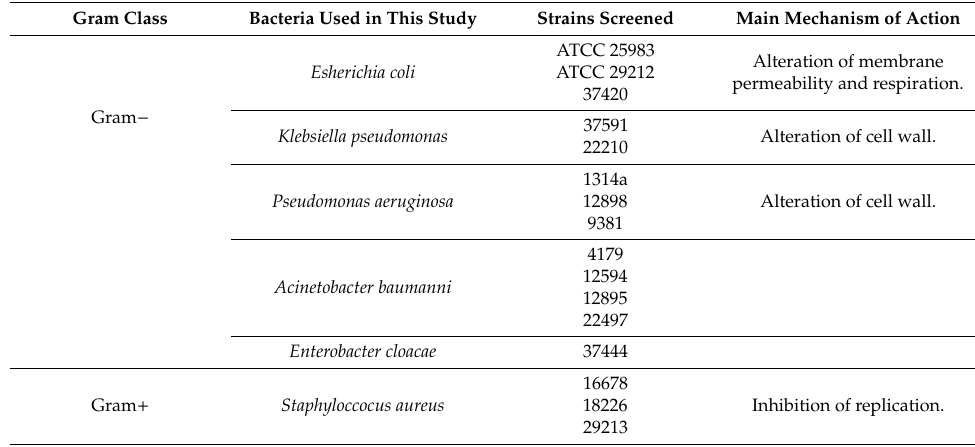
Table 3. Antibacterial activity screening strains used with ZnONPs and AgNPs and the main mechanisms of